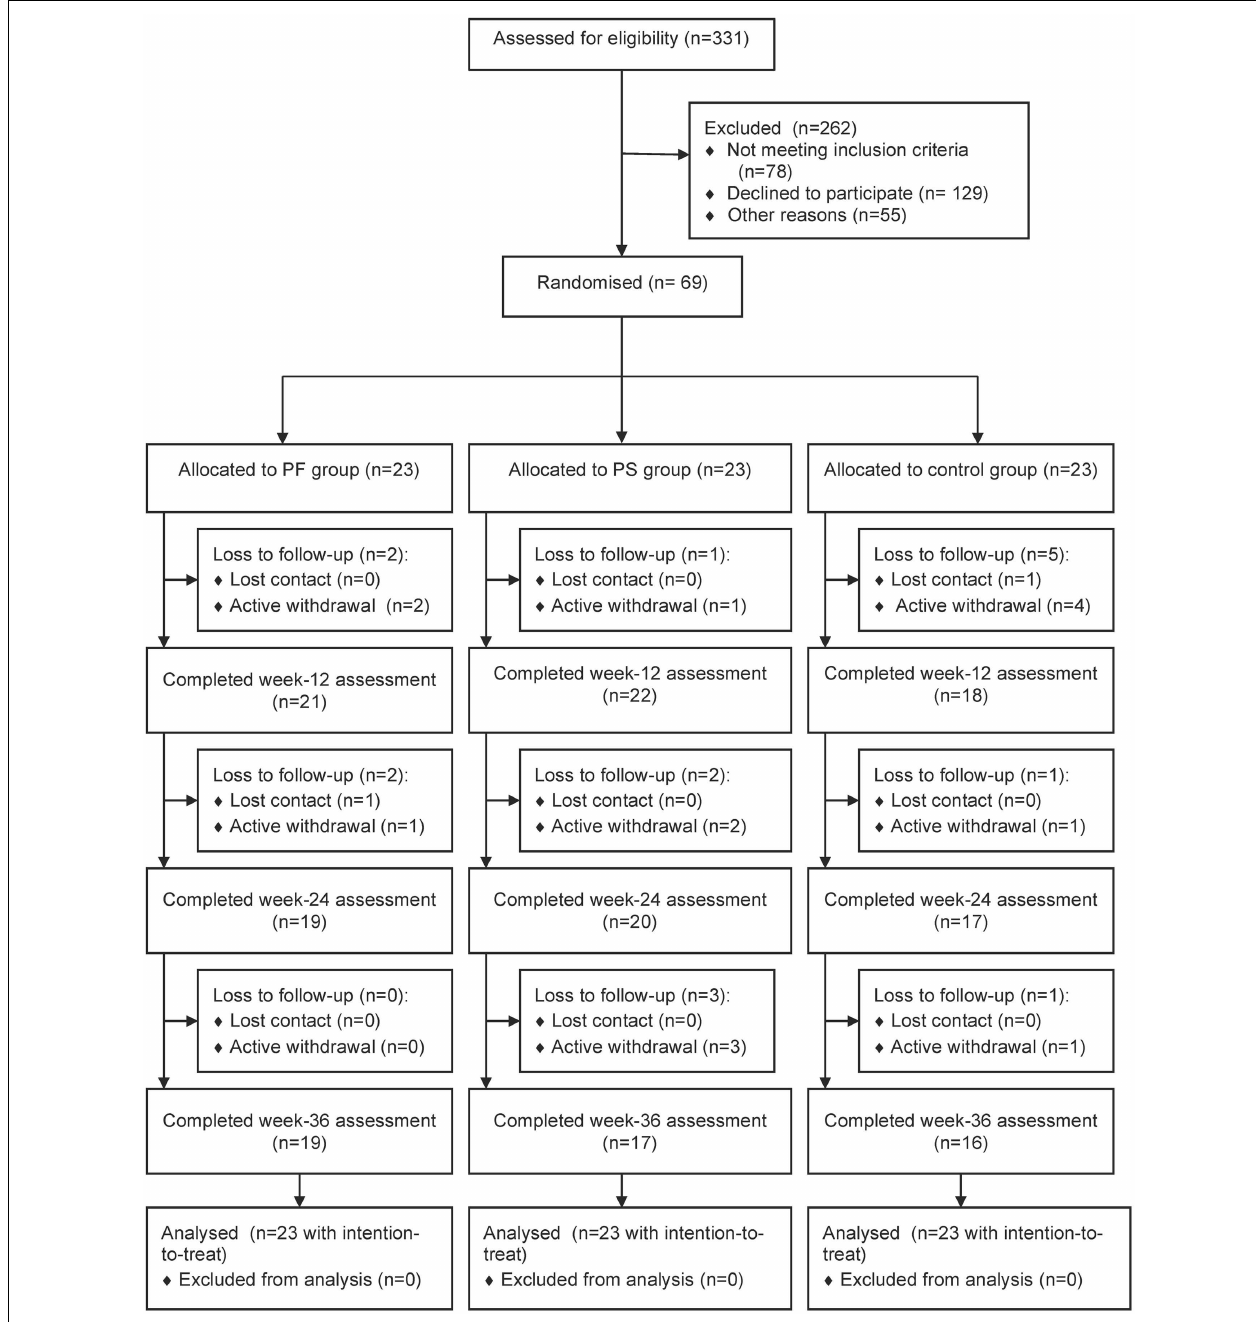
FIGURE 1 | Flow of study participants